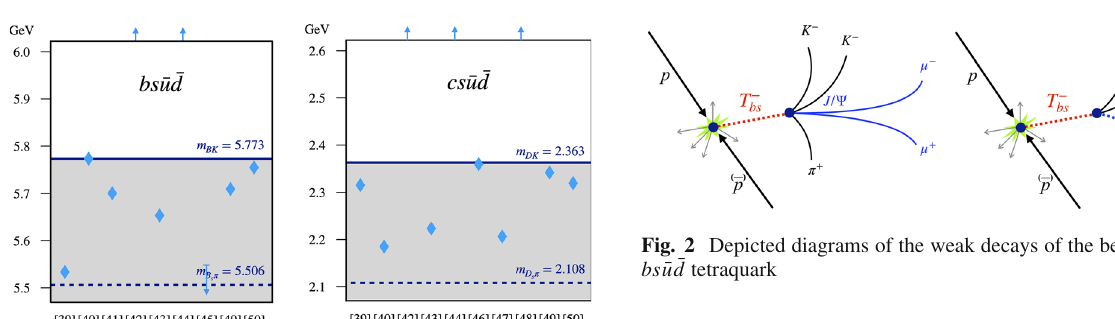
Fig. 1 Masses of the lightest states of bs ¯ u ¯ d and cs ¯ u ¯ d tetraquarks pre- dicted in literature